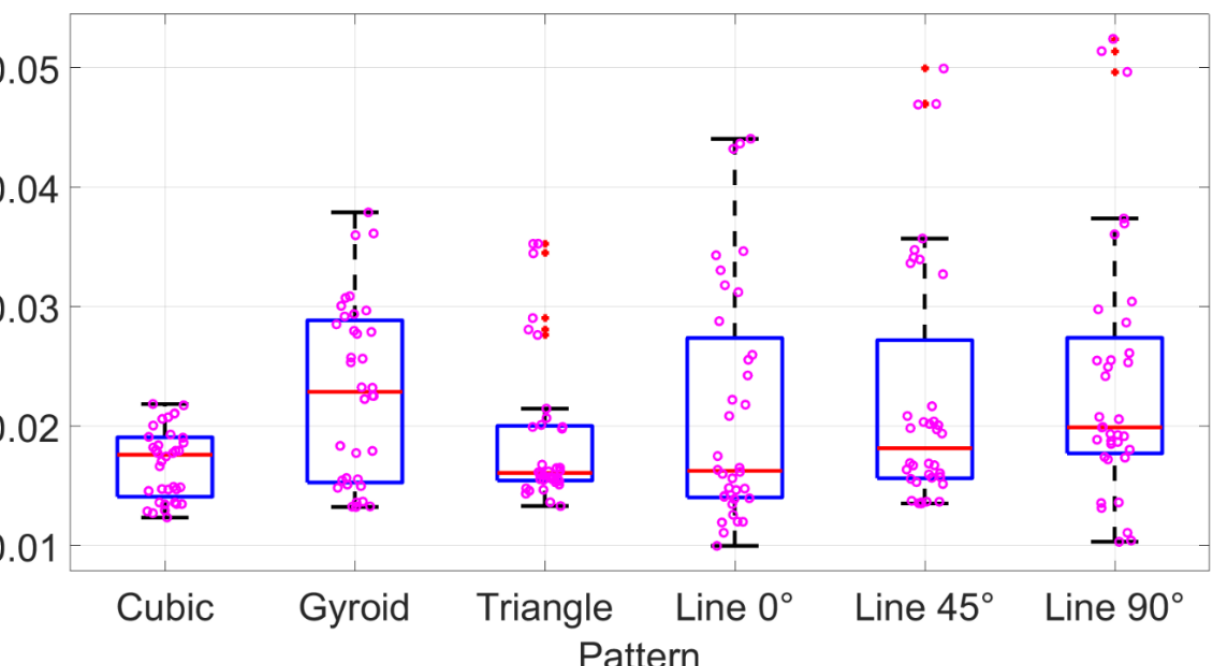
Table 2. ANOVA results ( n represents the sample size).